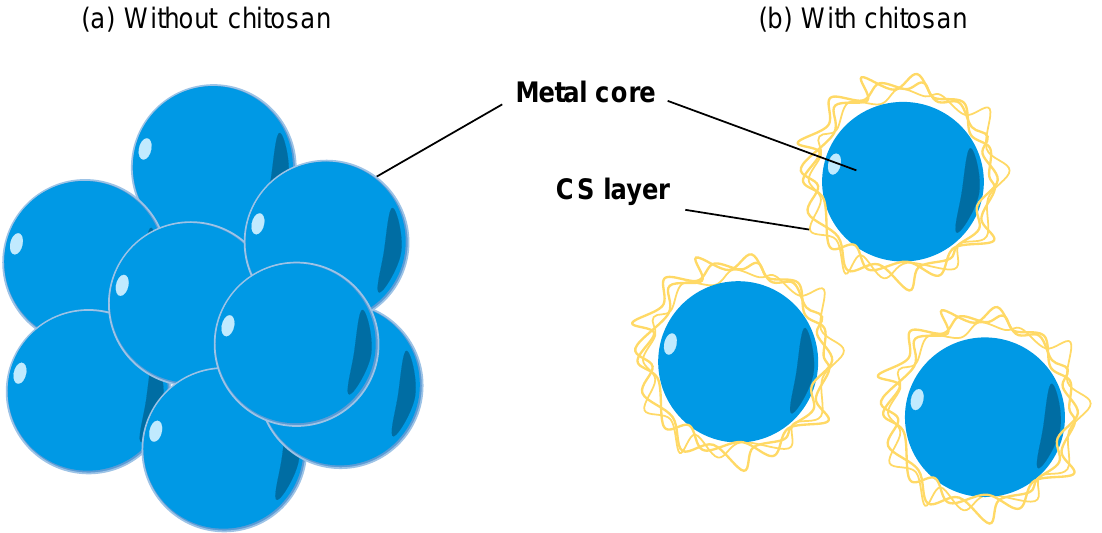
Figure 3. The effect of chitosan (CS) capping on the dispersion of metal nanoparticles. ( a ) The aggregation of metal nanoparticles without a CS capping agent in solution. ( b ) The good dispersion of metal nanoparticles with a CS capping agent in